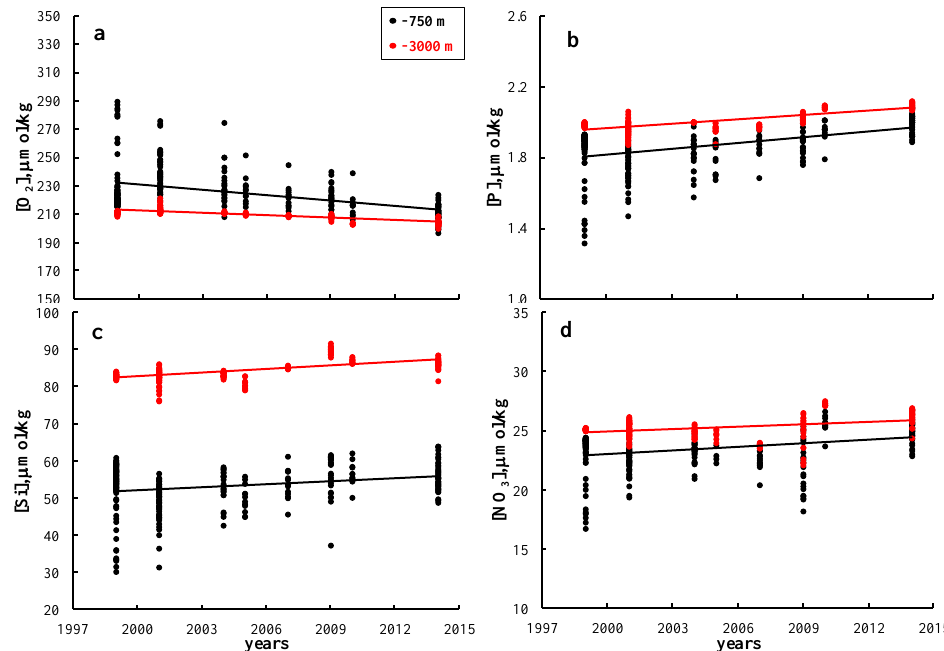
Figure 6. Temporal variability of the hydrochemical parameters in the JES at 750 m (black) and 3000 m (red) depths. ( a ) DO concentrations (µmol/kg); ( b ) phosphorus concentrations (µmol/kg); ( c ) silica concentrations (µmol/kg); ( d ) nitrate concentrations (µmol/kg).